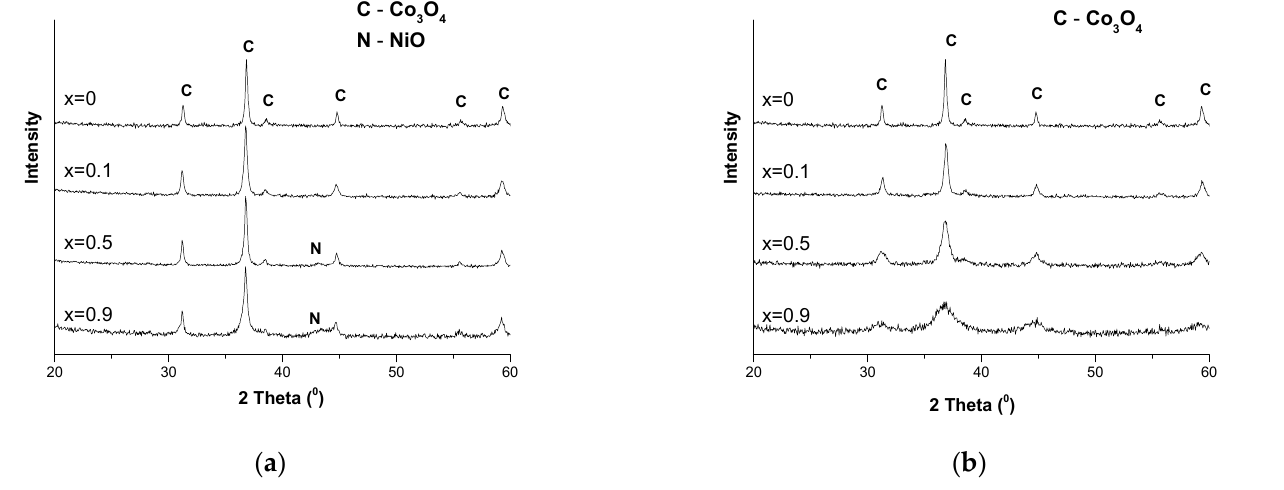
Figure 1. XRD patterns of samples: ( a ) Cs/Ni-Co; ( b ) Cs/Mg-Co.